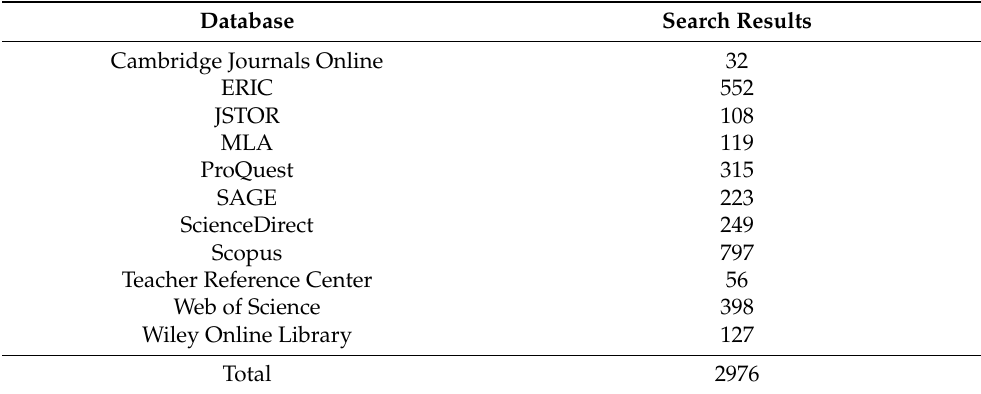
Table 1. Databases and search